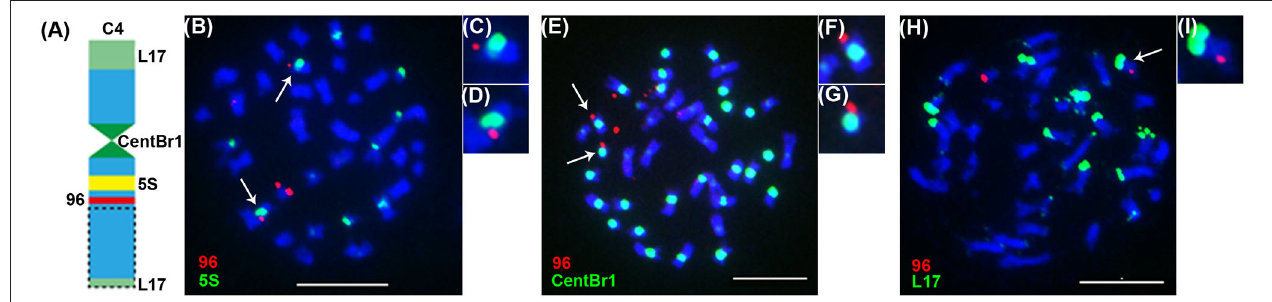
FIGURE 6 | Detection of the truncated chromosome C4 in 86-1-75-10-74 by multi-FISH. (A) The features of chromosome C4 in B. napus (Xiong and Pires, 2011) and the site hybridized by pWY96 probe (red). 5S rDNA (5S; yellow) was located on the long arm of chromosome C4 near the centromere, a strong and a weak signals of BAC clone KBrB072L17 (L17; pale green) were located on chromosome C4 at the end of its short and long arms, respectively, and CentBr1 (green) repeats could be visualized in B. napus chromosome C4 (Xiong and Pires, 2011). (B,E,H) were hybridized with the labeled pWY96 probe, and they were also hybridized with the labeled 5S, CentBr1 and L17 probes, respectively. (C,D) , (F,G) , and (I) focusing on C4 were derived from (B,E,H) , respectively. 5S rDNA, L17 and CentBr1 were labeled with Alexa Fluor TM 488-5-UTP (green), and pWY96 was labeled with Texas Red-5-dCTP (red). The arrows indicated chromosome C4. Here, owing to the telomere-mediated truncation of chromosome C4, the weak signal of BAC clone KBrB072L17 was lost in C4 at the end of its long arm. Scale bar = 10 µ